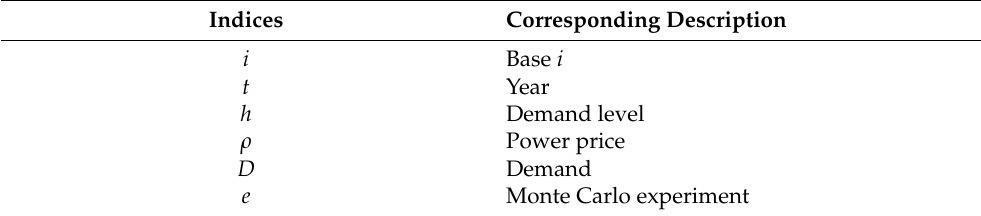
Table 2. The explanation of indices associated with